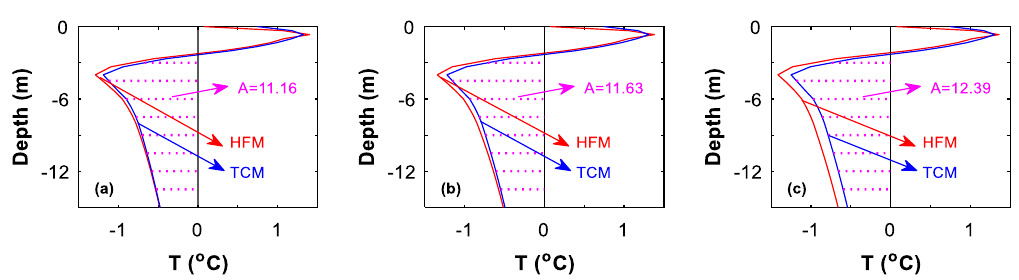
Figure 9. The northern side-slope borehole temperature profile predicted by HFM is compared with that by TCM. Date: on October 27. ( a ) 5th year, ( b ) 10th year, and (c ) 50th